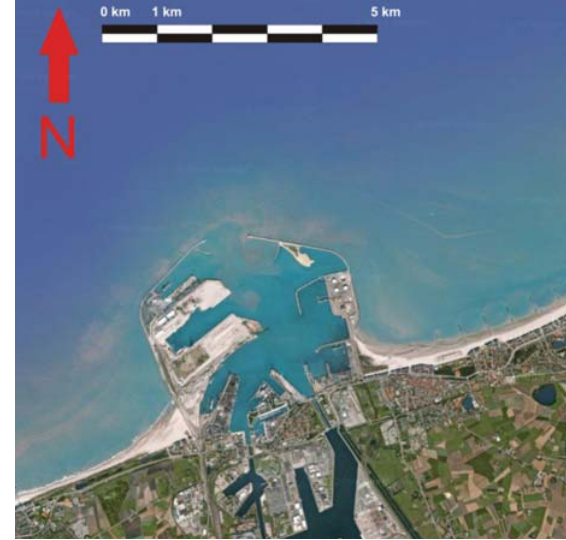
Fig. 1. Th e Port of Zeebrugge